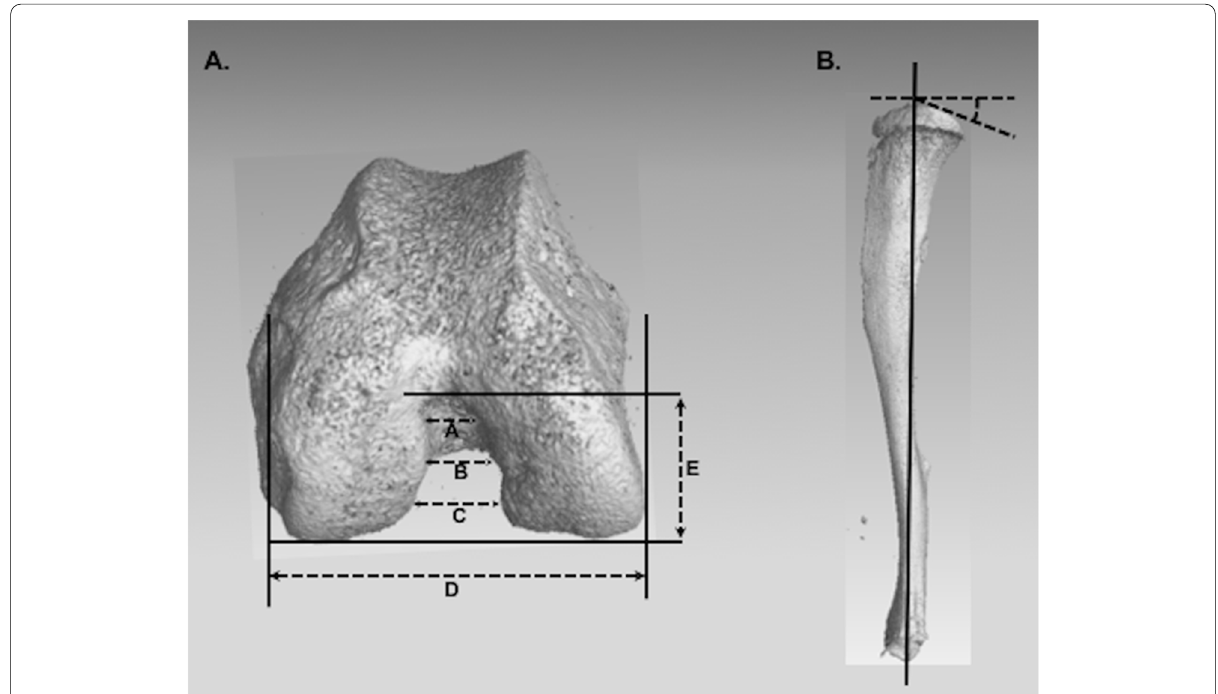
Fig. 2 Femoral and tibial measurements. A 8 μm voxel image of distal femur demonstrating the intercondylar notch measurements (A. Ant.Not. Wi; B. Cen.Not.Wi; C. Post.Not.Wi; D. Fem.Bicon.Wi; E. Not.Ht). B 8 μm voxel image of proximal tibia demonstrating tibial plateau measurements. Solid line marks the longitudinal axis; dotted lines mark the perpendicular to the longitudinal axis and the angle of the posterior tibial slope from perpendicular. Reproduced with permission from